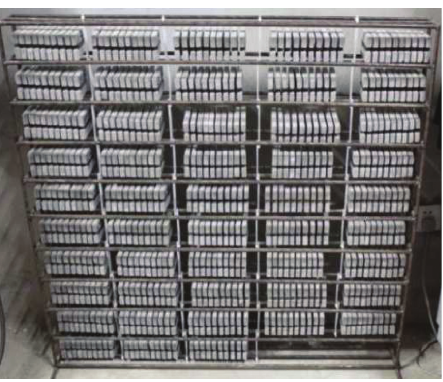
Figure 1: Some prepared PCC specimens.